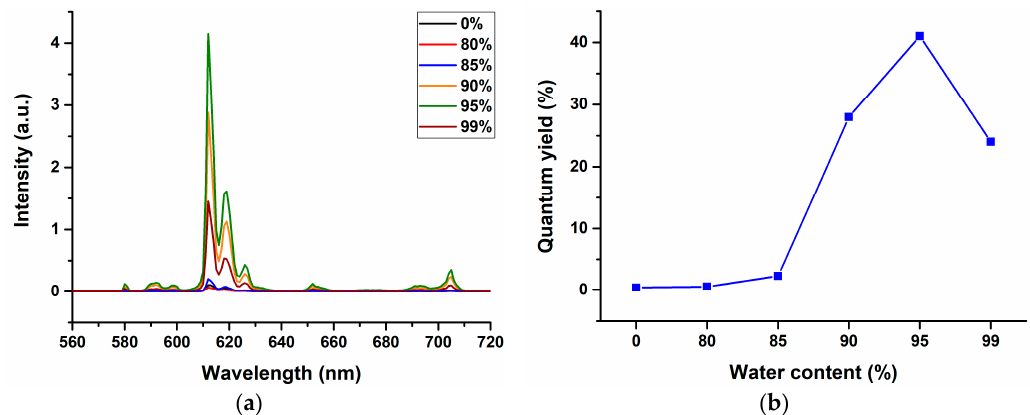
Figure 7. ( a ) Photoluminescence spectra of [Eu( pp -dbm-Cl 2 ) 3 phen] in THF/water mixture at different water content ( f w ), Measurement condition: λ ex = 360 nm, slit = 1.0–0.3, and longpass filter = 380 nm. ( b ) Trend of quantum yield of [Eu( pp -dbm-Cl 2 ) 3 phen] in THF/water mixture at different water content.